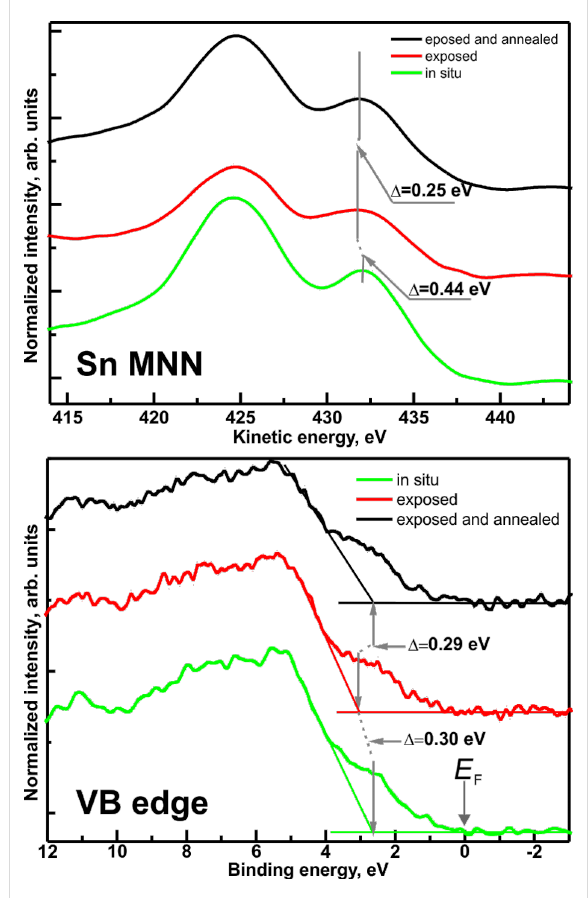
Figure 4: (a) Auger Sn MNN energy region recorded for pristine (in situ) and air-exposed SnO 2 layers. The shift of the characteristic SnO 2 transition is well visible (marked with grey vertical lines). (b) Valence band (VB) region of XPS spectra for pristine (“in situ”), air-exposed and annealed samples. The characteristic shape of the SnO 2 valance region can be recognized [32].